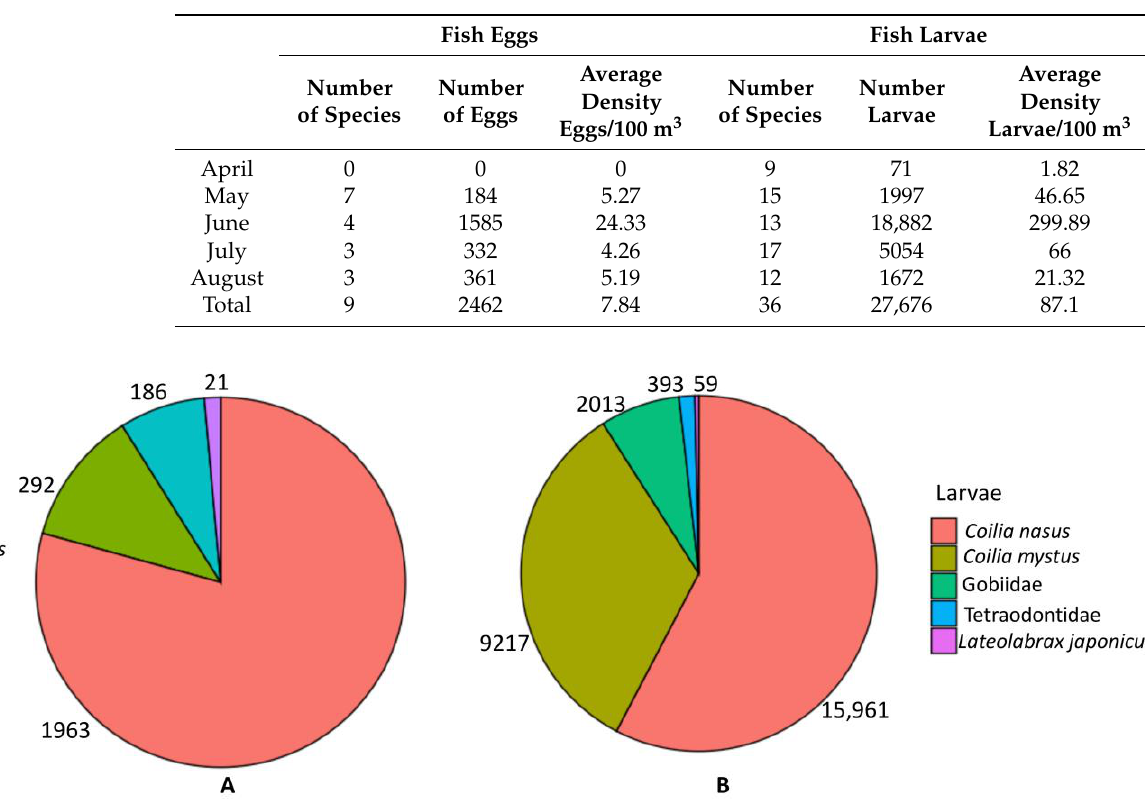
Table 1. Species number, quantity and average density of fish eggs and larvae in Oujiang River Estuary from April to August 2015.